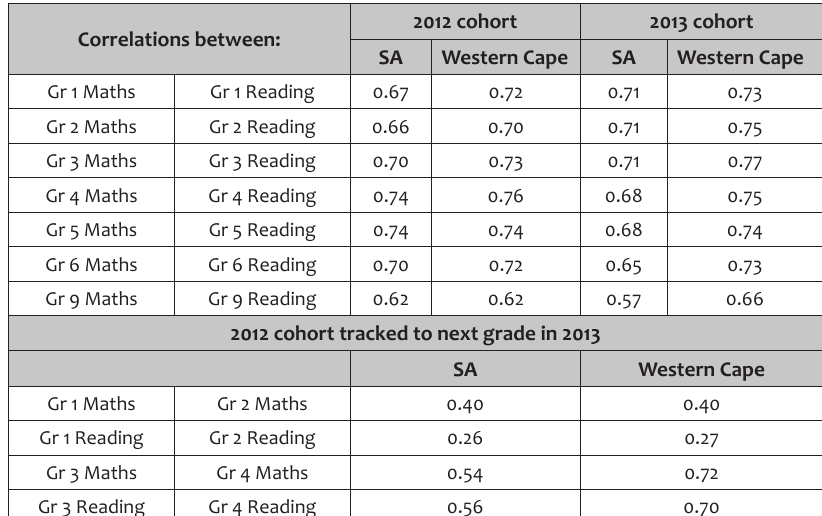
Table 3: Correlations in ANA Mathematics and Reading, 2012 and 2013 (Source: Own calculations from ANA